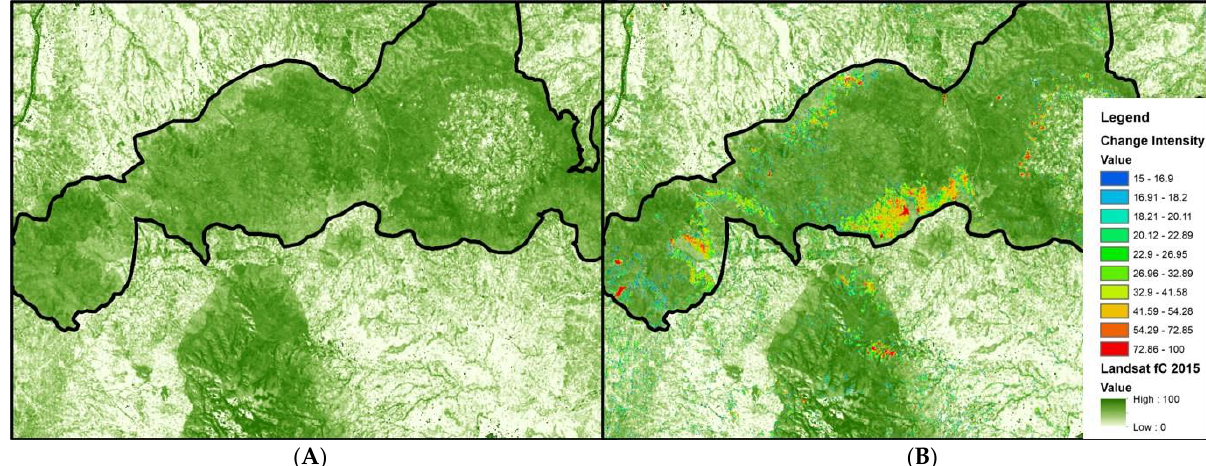
Figure 2. The f C model of forest cover and change measures the intensity of forest disturbance as a continuous field of observations. ( A ) The f C forest cover product for 2015, where shading of green represents a continuous field of forest cover. ( B ) Using change detection, ∆ f C, is computed from two dates and presented as a continuous gradient of change. If the change is significant it is labeled as deforestation. If the change is within the range of f C values for forest, the intensity of degradation can be estimated and mapped as shown here, where tones of blue and green are low-intensity degradation, and tones of orange and red are high-intensity degradation.